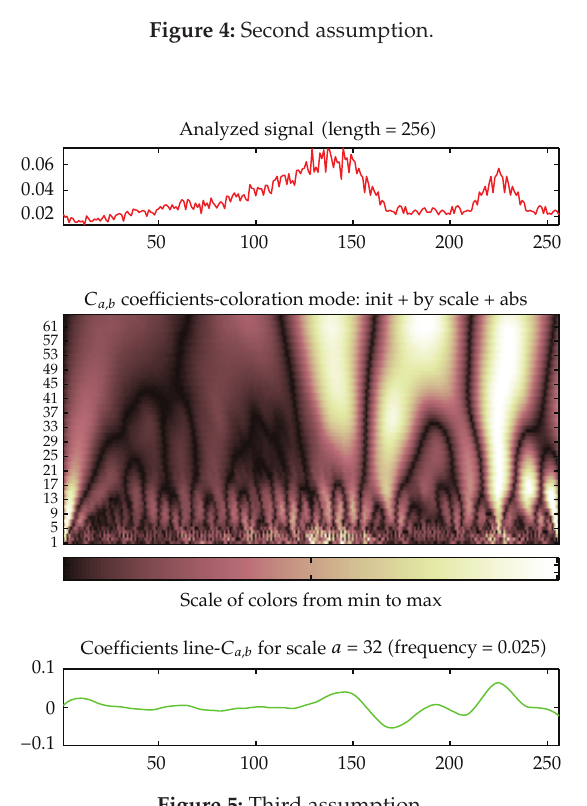
Figure 4: Second assumption.